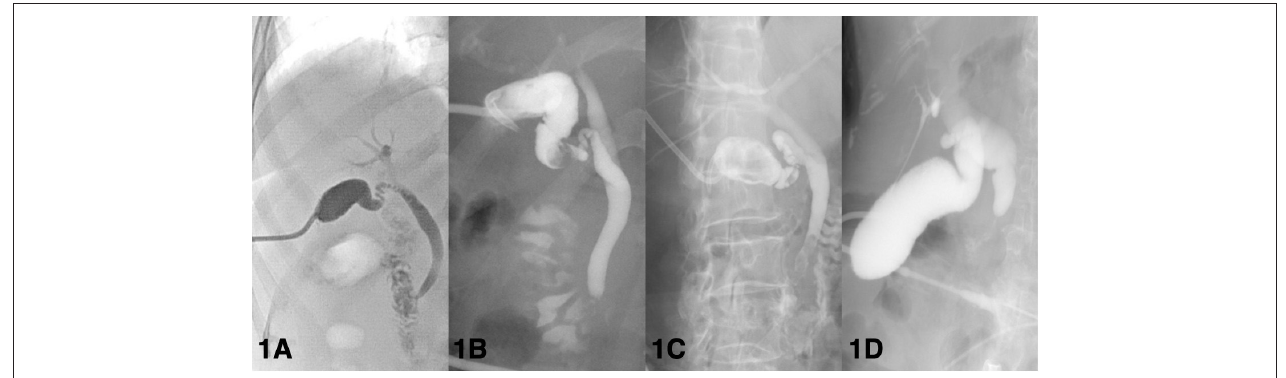
FIGURE 1 | Various definitions of patent biliary tree according to cholangiography findings. (A) Patent biliary tree. Both the cystic duct and common bile duct are patent to the duodenum. (B) Gallstones at the gallbladder neck. Patent cystic duct and common bile duct. (C) Choledocholithiasis. Patent cystic duct. (D) Occluded distal common bile duct without opacification of the